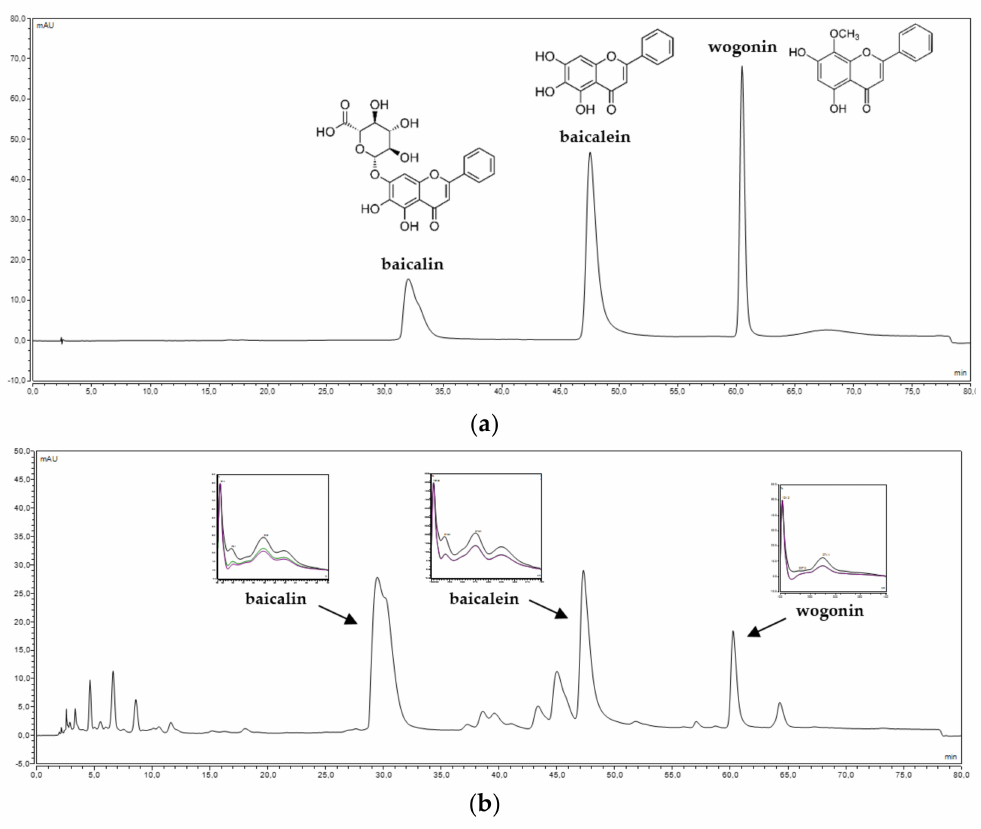
Figure 1. Spectral and chromatographic analysis of ( a ) baicalin, baicalein, and wogonin standards and ( b ) S. baicalensis radix lyophilized